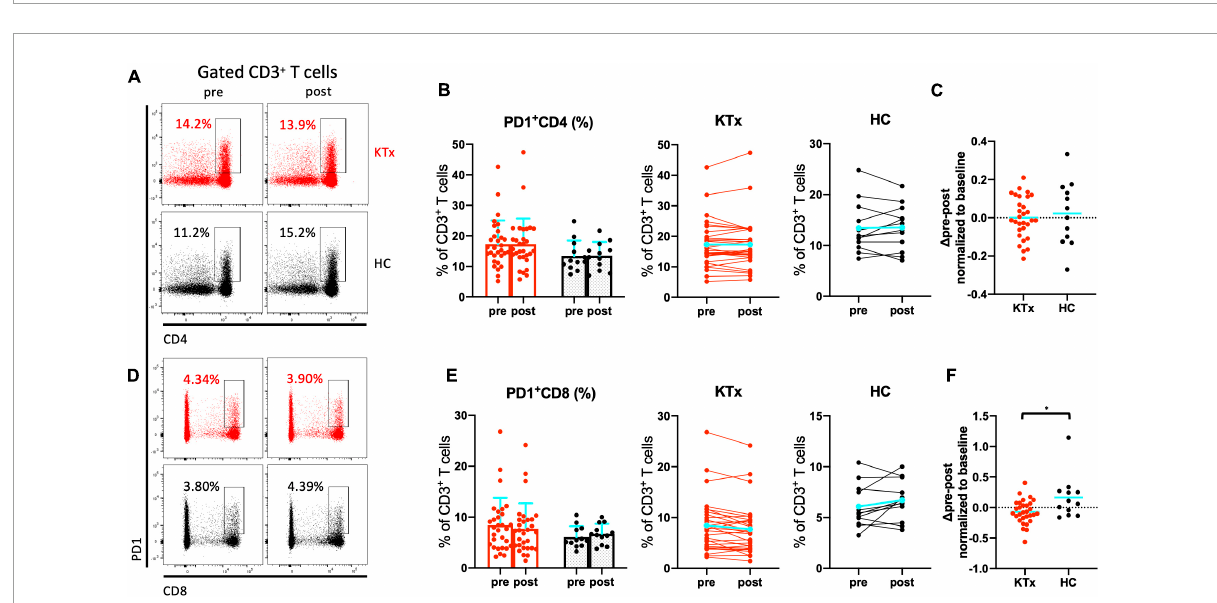
FIGURE5 PD1 + CD8 + T cells were induced by SARS-CoV-2 mRNA vaccination in HCs. Representative gating strategies and scatter plots of activated PD1 + cells among T cell subsets in the two groups pre- and post-vaccination (A,D) . Comparison of the proportions and change in proportions of PD1 + cells among CD4 + (B) and CD8 + (E) T cells in KTx recipients (left) and HCs (right) as measured by flow cytometry. Normalized increases in PD1 + cells among CD4 + (C) and CD8 + (F) T cells between pre- and post-vaccination. Bar plots depict mean ± SD. Blue lines and bars represent means. Data were analyzed using the Mann-Whitney U test (* P < 0.05).